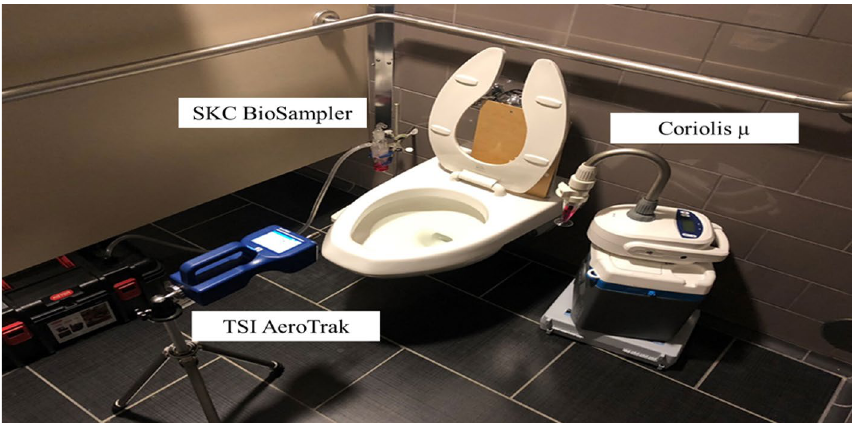
Figure 2 . Sampling setup for MNV aerosolization experiments around an FOM toilet located at ITF on UI Research